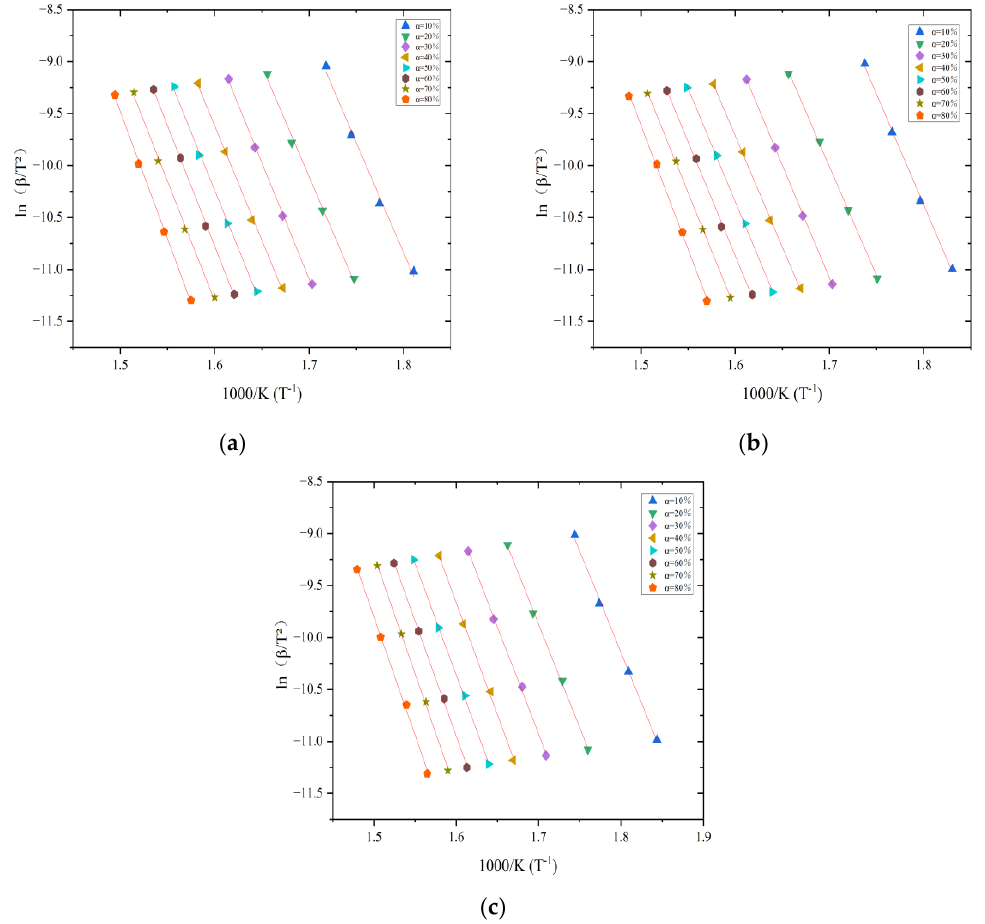
Figure 5. Linear regression diagram of KAS method under different conversion rates: ( a ) natural aging − 10; ( b ) natural aging − 70; ( c ) natural aging − 100. Table 2. EstimationofactivationenergyateachconversionbasedonFWOandKASmethods.